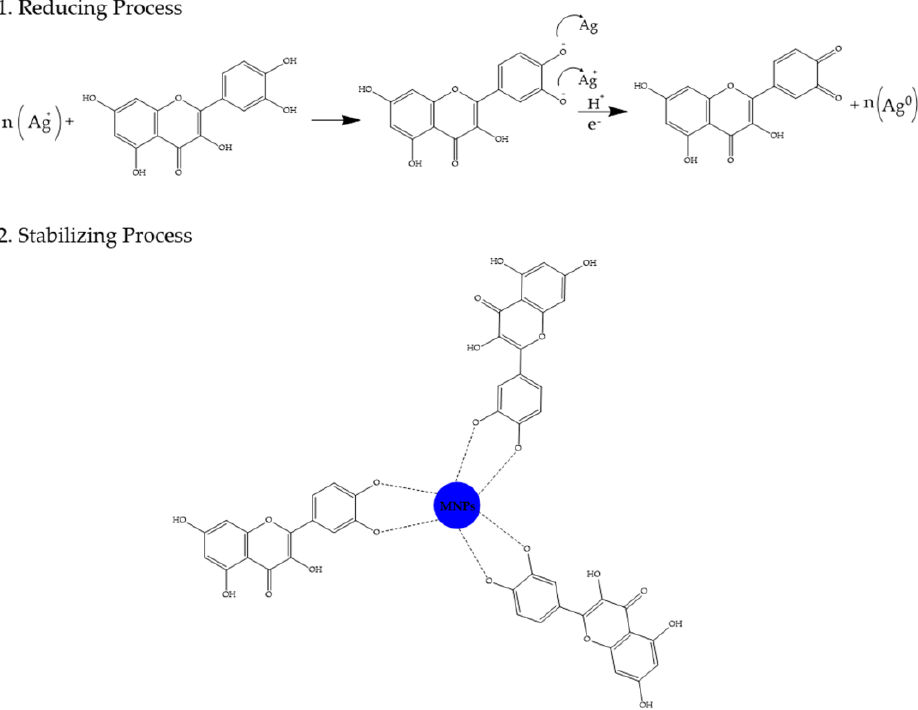
Figure 2. Schema of reducing and stabilizing NPs utilizing polyphenols (e.g., the flavonoid quercetin).